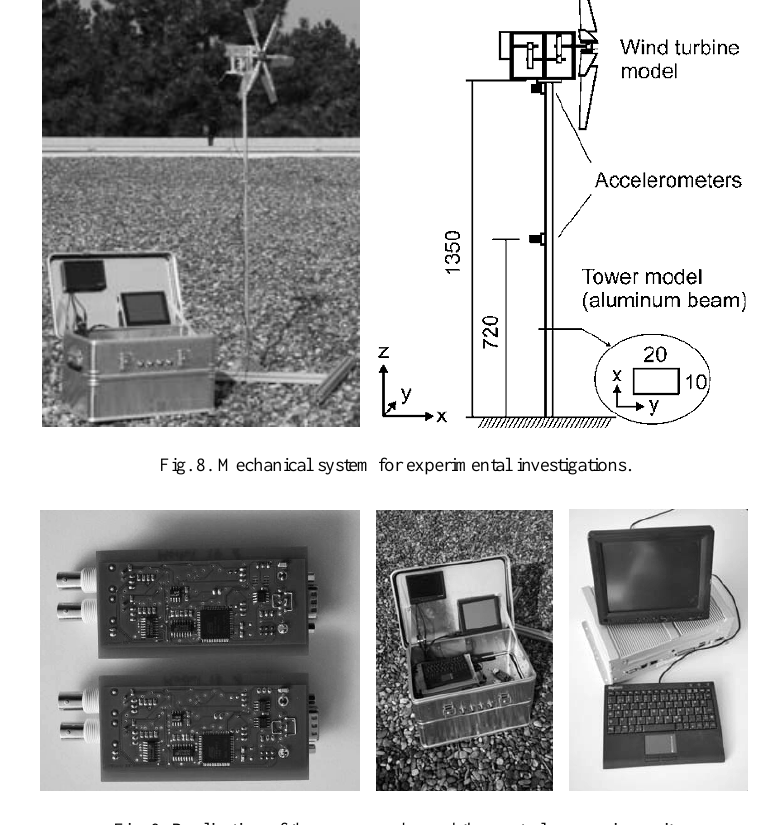
Fig. 9. Realisation of the sensor nodes and the central processing